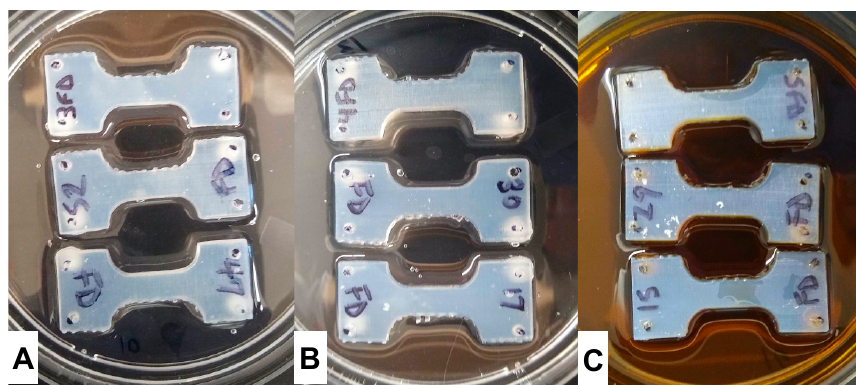
Figure 2. Micro-tensile sample liquid exposure at 37 ◦ C. ( A ) Representative samples in water, ( B ) in PBS, pH 7.4, ( C ) in bile acid solution, pH 6.7. Samples were placed in 60 mm petri dishes with 30 mL of designated liquid and placed in incubator (N = 6 per liquid and time point). Note samples were not submerged in liquids.